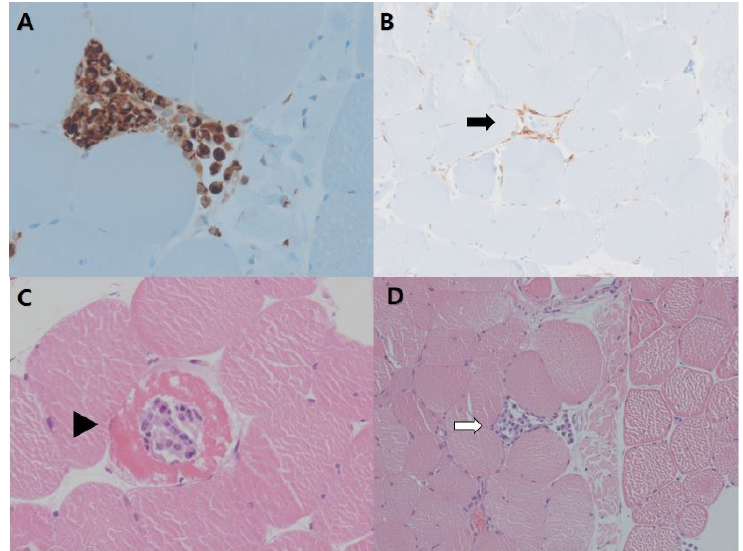
Figure 3. Muscle biopsy from the right vastus lateralis ( A ) Necrotic tissue infiltrated by macrophages (immunohistochemistry, CD68 stain) ( × 400) ( B ) Scant endomysial infiltration of CD4+ T-lymphocytes (arrows) (immunohistochemistry, CD4 stain) ( × 200) ( C ) Scattered necrotic myofibers (arrowhead) ( × 400) ( D ) with phagocytosis (white arrows) (high power field, Hematoxylin and eosin stain) ( ×